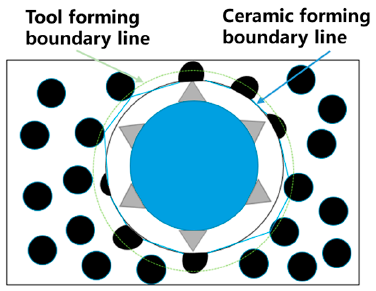
Figure 2. Tendency of microporous surface forming changes.